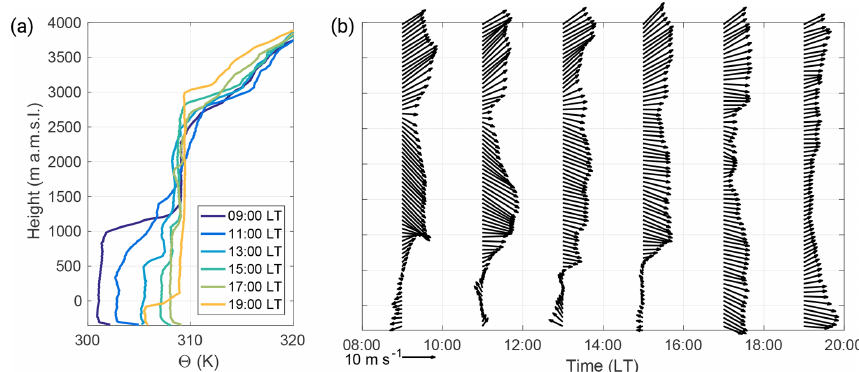
Figure 8. Potential temperature (a) and horizontal wind profiles (b) , measured with radiosondes in the valley at the KITcube location. Data are shown for 16 August 2014.